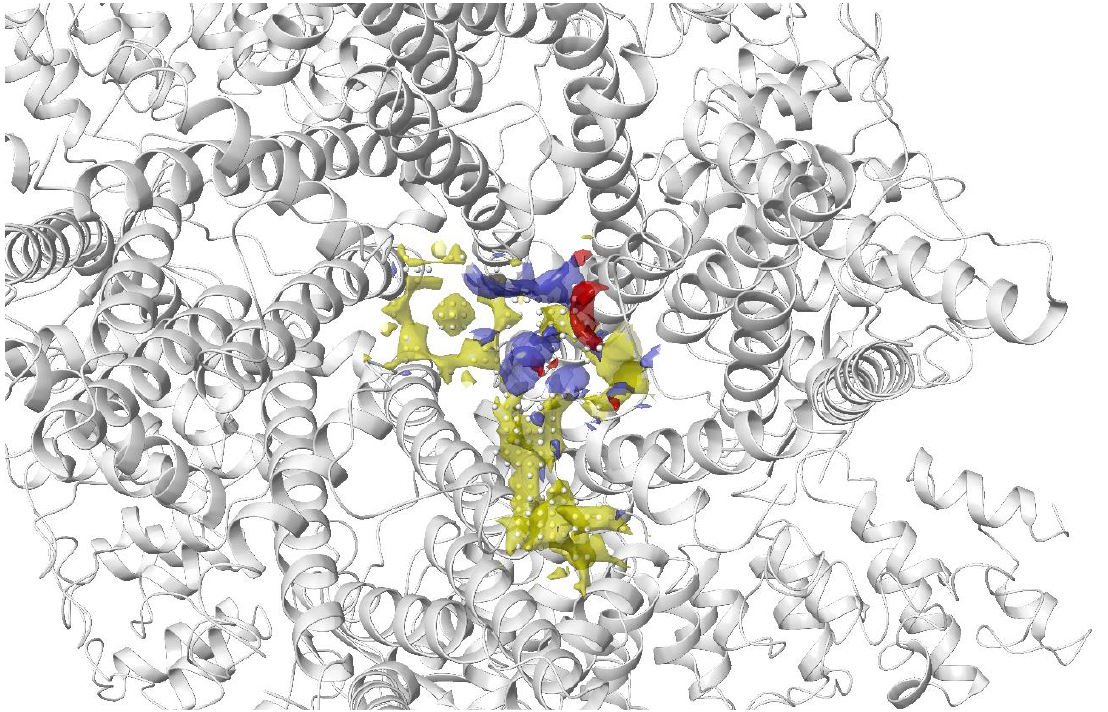
Figure 6. Binding site of TRPV4 detected using Sitemap by Doñate-Macian et al. [131]. Yellow: hy- drophobic region; blue: H-bond donor region; red: H-bond acceptor region; white sphere: site point.